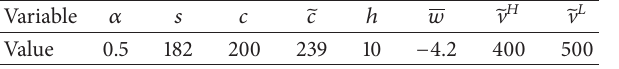
Table 1: Simulation parameters.